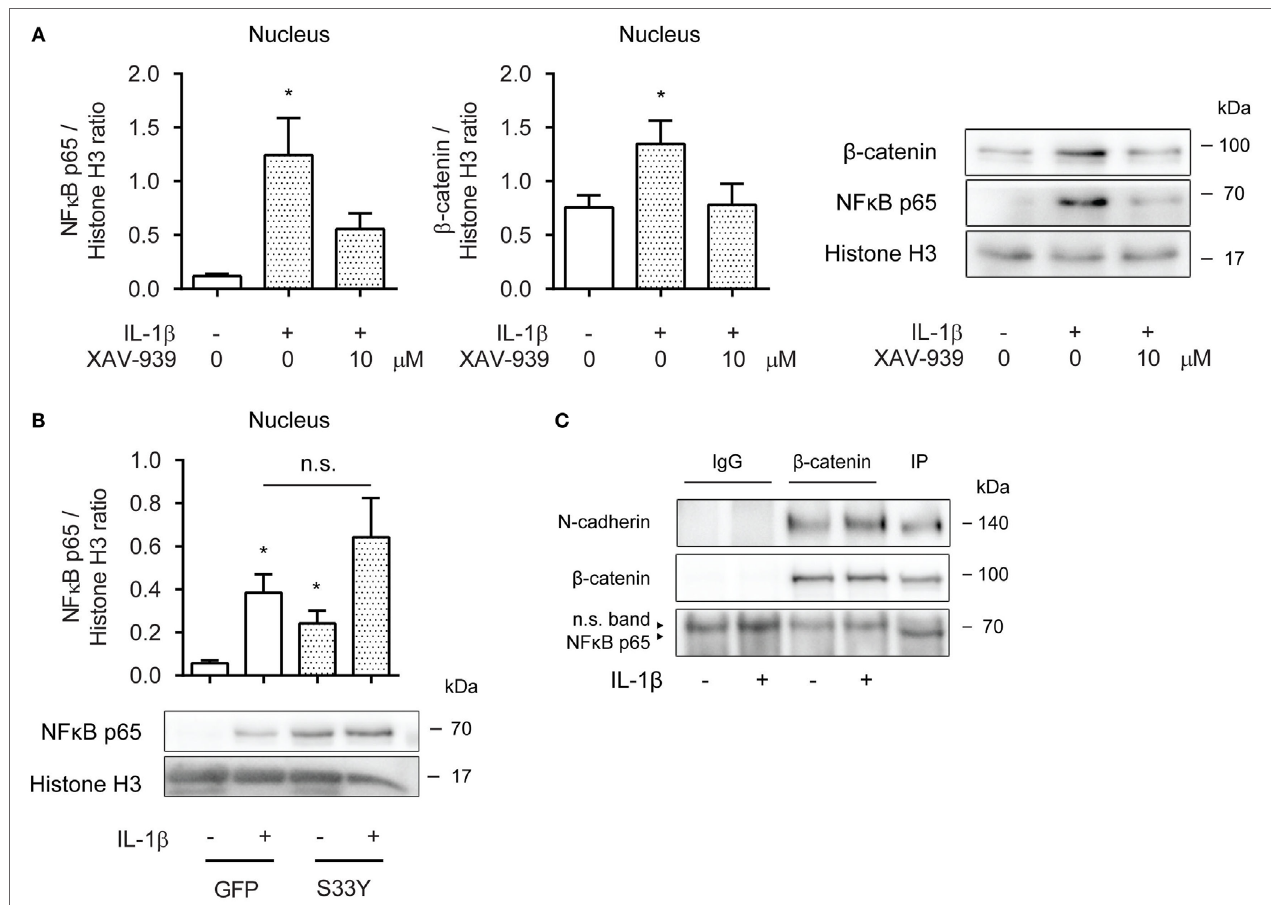
FigUre 3 | β -Catenin is required for p65 nuclear translocation. (a) Nuclear extracts were used to immunoblot nuclear factor- κ B (NF- κ B) p65 and β -catenin and normalized against Histone H3. Cells were pretreated with XAV-939 (10 µM) or DMSO for 16 h, after which they were stimulated with IL-1 β (1 ng/mL) for 30 min. Data represent six independent experiments. (B) Nuclear extracts were used to immunoblot NF- κ B p65 and normalized against Histone H3. Cells were transiently transfected with a green fluorescent protein (GFP) or S33Y-construct for 24 h, and then treated with IL-1 β for 30 min. Data represent nine independent experiments. (c) Human airway smooth muscle cells were exposed to IL-1 β (1 ng/mL) for 30 min. Stimulated lysates were subjected to immunoprecipitation using a β -catenin specific antibody and mouse IgG as control and were subsequently subjected to SDS-PAGE followed by Western blot using the indicated antibodies. * vs.